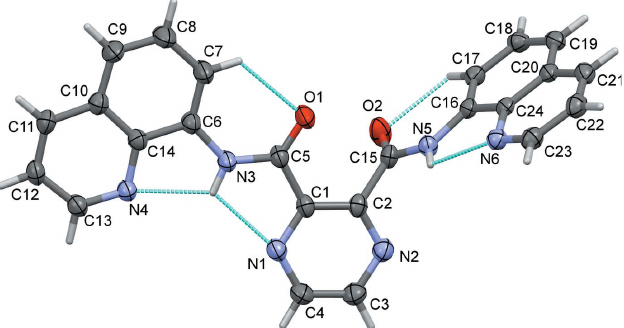
(Fig. 1, Table 1). Both carboxamide O atoms, O1 and O2, are